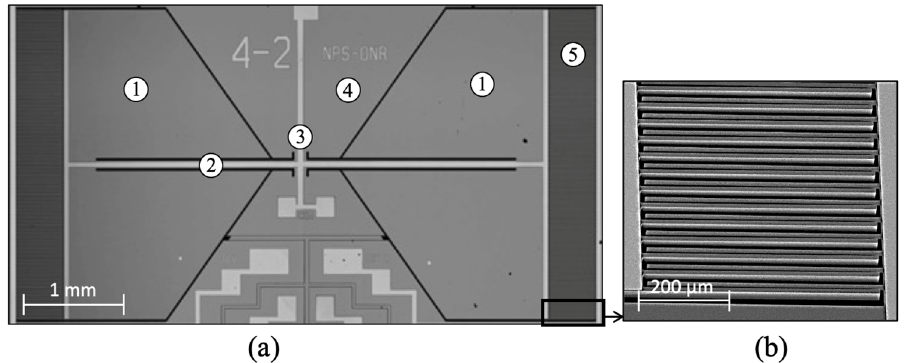
Figure 3. Fabricated MEMS sensor: ( a ) Optical microscopy image of the Gen 4-2 sensor. Metallized pads and tracks appear brighter than the substrate gray. The numbers on the image represent: ① Wing; ② Bridge; ③ Pivot point; ④ Substrate; ⑤ Capacitive comb fingers. ( b ) Scanning electron microscope image of the comb finger capacitors.